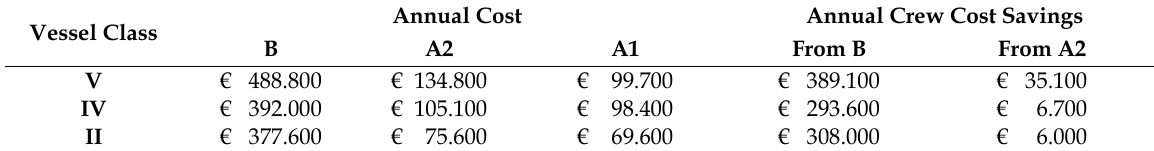
Annual Crew Cost and Saving for the Different Operating